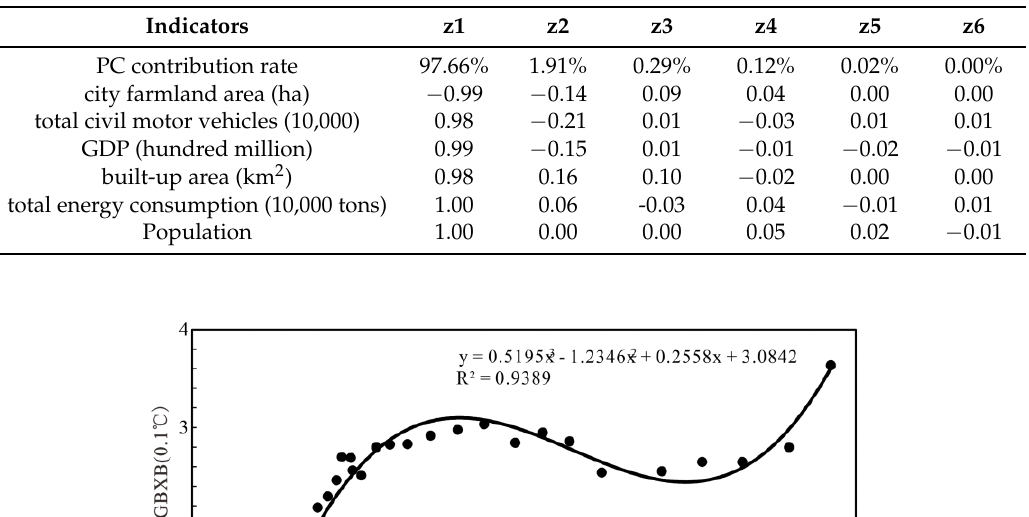
Table 3 . Principal component analysis.